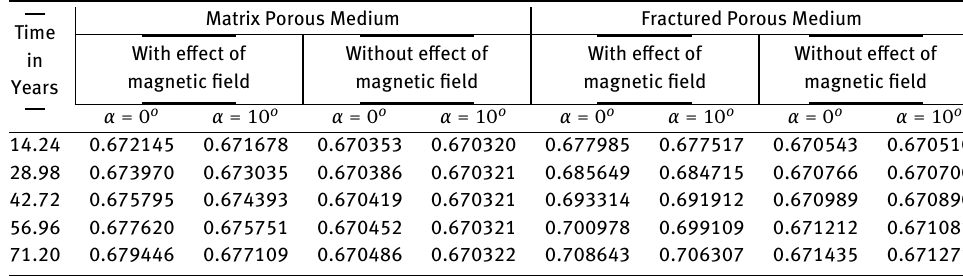
Table 5: Numerical values of saturation rate in fine sand in an inclined fractured and matrix porous medium with the effect of magnetic field